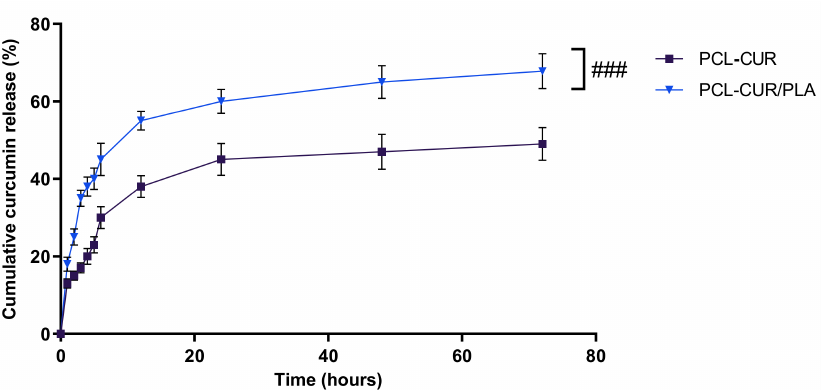
Figure 4. Cumulative curcumin release kinetic release profiles at 37 ◦ C of PCL, and PCL-Cur/PLA incubated for 72 h in release medium (PBS/EtOH 90:10 v/v ). For each sample, six different experi- ments were conducted, and the results expressed as the mean of the values obtained (mean ± SD). Statistically significant variations: ### p < 0.001 versus PCL-CUR.